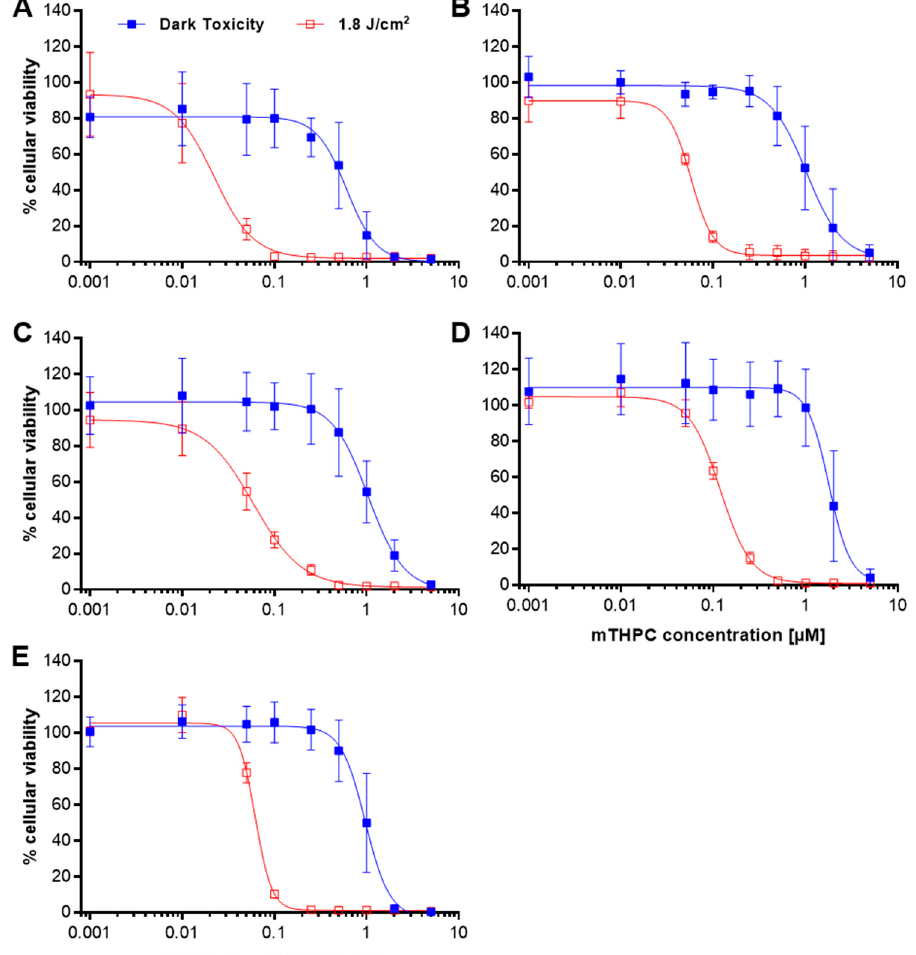
Figure 1. Dark ( ■ ) and light-induced ( □ ) loss of cellular viability after mTHPC treatment as assessed by MTT viability assay. The five cell lines A-427 ( A ), BHY ( B ), KYSE-70 ( C ), RT-4 ( D ), and SISO ( E ) were treated with mTHPC for 24 h in concentrations ranging from 0.001–5.0 µM and kept in the dark (dark toxicity) or illuminated with a light dose of 1.8 J/cm 2 (light-induced toxicity). MTT assay was carried out 24 h post illumination and the absorbance of the reduced formazan was measured at λ = 570 nm. The percentage of cell viability was calculated by dividing the absorbance for the treated group by the absorbance in the solvent dark control. IC 50 and IC 90 values were calculated by using Prism 6. Results are presented as means ± SD from at least three independent experiments.